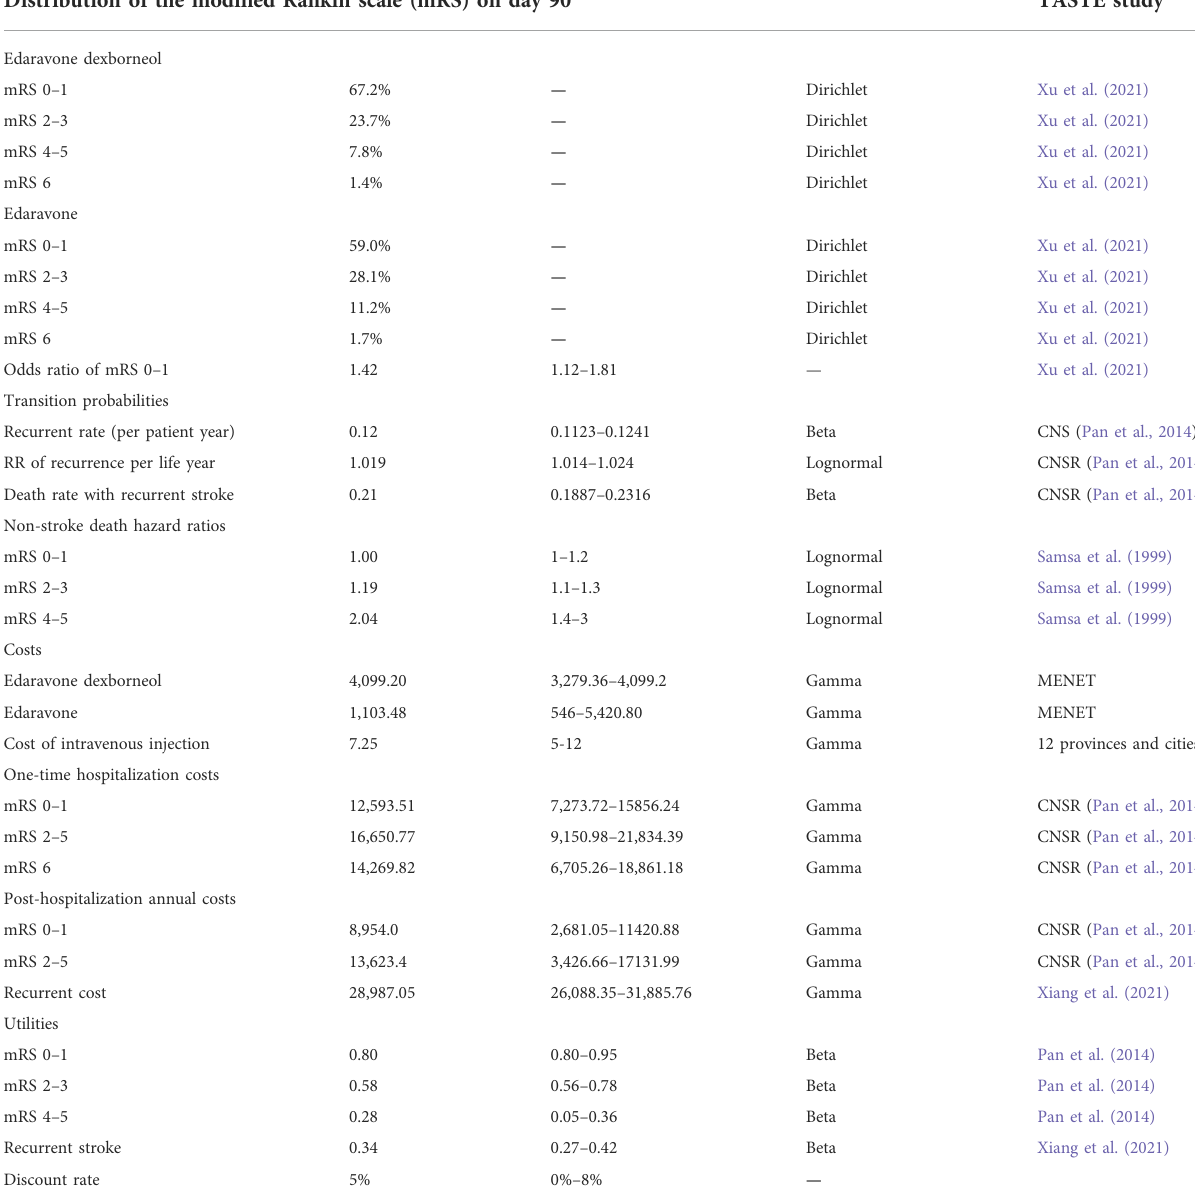
TABLE 1 Model input